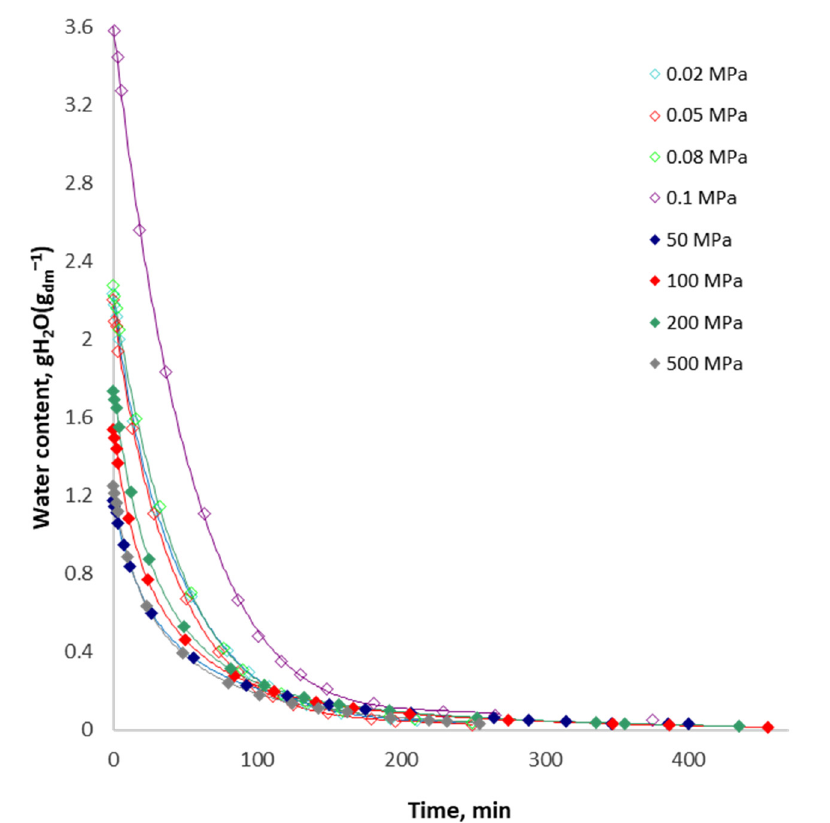
Figure 2. The course of the drying curves of apples initially osmotically dehydrated under varied pressure.